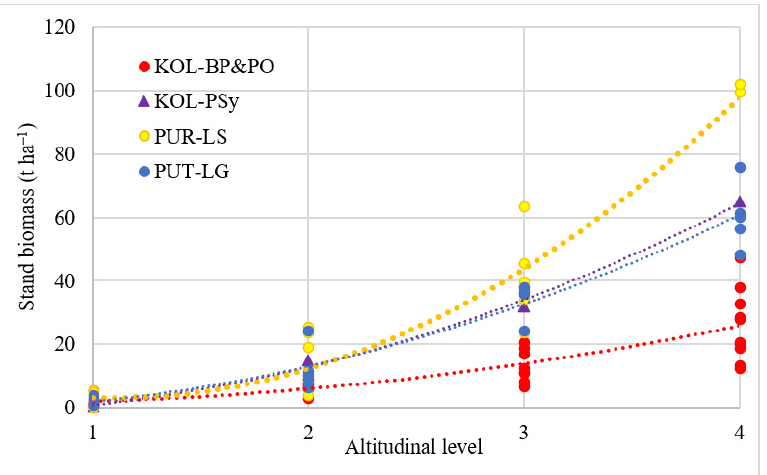
Figure 4. Aboveground biomass of stands dominated by different species (PO— Picea obovate , BP— Betula pubescens ssp. tortuosa, PSy— Pinus sylvestris , LS— Larix sibirica , LG— Larix gmelinii ) on four altitudinal levels (1—sparse tree stands line; 2—open forests line; 3—contemporary closed forest line; and 4—historical (in 1950s–1960s) closed forest line) of forest–tundra transition in three subarctic regions of Russia (KOL—Kola Peninsula; PUR—Polar Urals; and PUT—Putorana Plataeu). Lines represent fitted polynomial